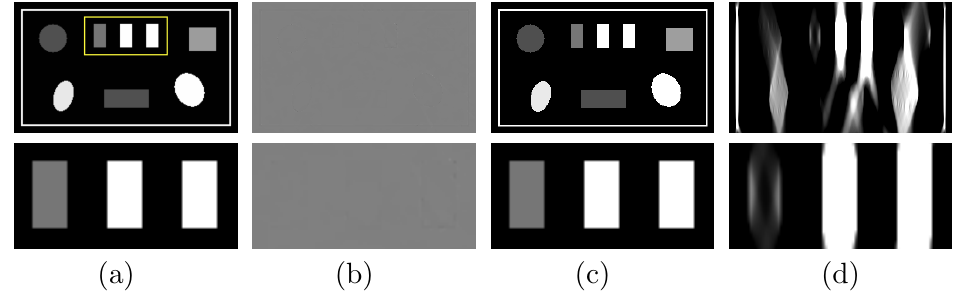
Figure 8. Row 1: ( a ) VMI of the suitcase phantom at 40 keV obtained with the two-step method from FAR data, ( b ) difference between the VMI in ( a ) and its truth in Figure 2c, VMIs at 40 keV obtained with ( c ) the two-step method and ( d ) the FBP algorithm from data acquired over a SA of LAR 30 ◦ ; and row 2: zoomed-in views of their corresponding images in row 1. The zoomed-in area is enclosed by the rectangular box depicted in the VMI in ( a ). Display windows [0.1, 0.65] cm − 1 for columns ( a , c , d ), and [ − 10 − 4 ,10 − 4 ] cm − 1 for column ( b